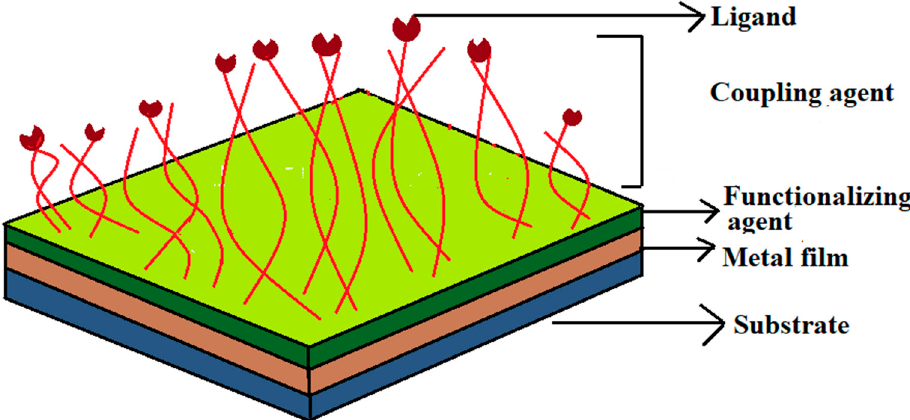
Figure 1. Representation of protein immobilization scheme.